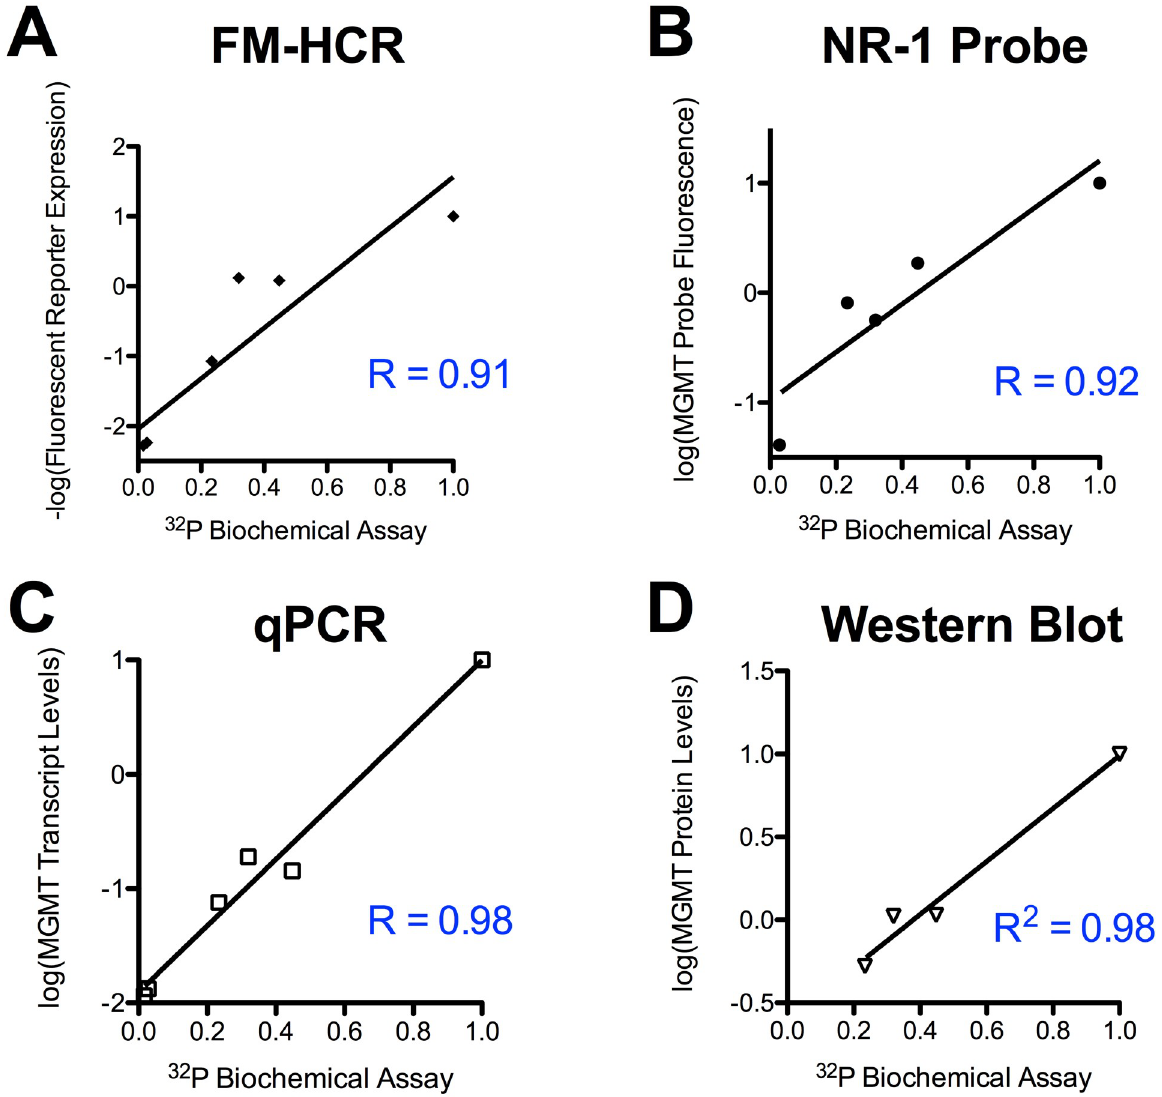
Fig 2. Comparison of four quantitative MGMT assays against the biochemical MGMT assay with radiolabeled oligonucleotides. All assays have been normalized to a control cell line (TK6+MGMT), which expresses a high level of MGMT. The Pearson correlation (R) to MGMT activity measured using biochemical assays with 32 P-labeled oligonucleotide substrates is reported for each assay. Each data point represents one of the seven cell lines analyzed; fewer data points are reported for assays where some cell lines were below the limit of detection.